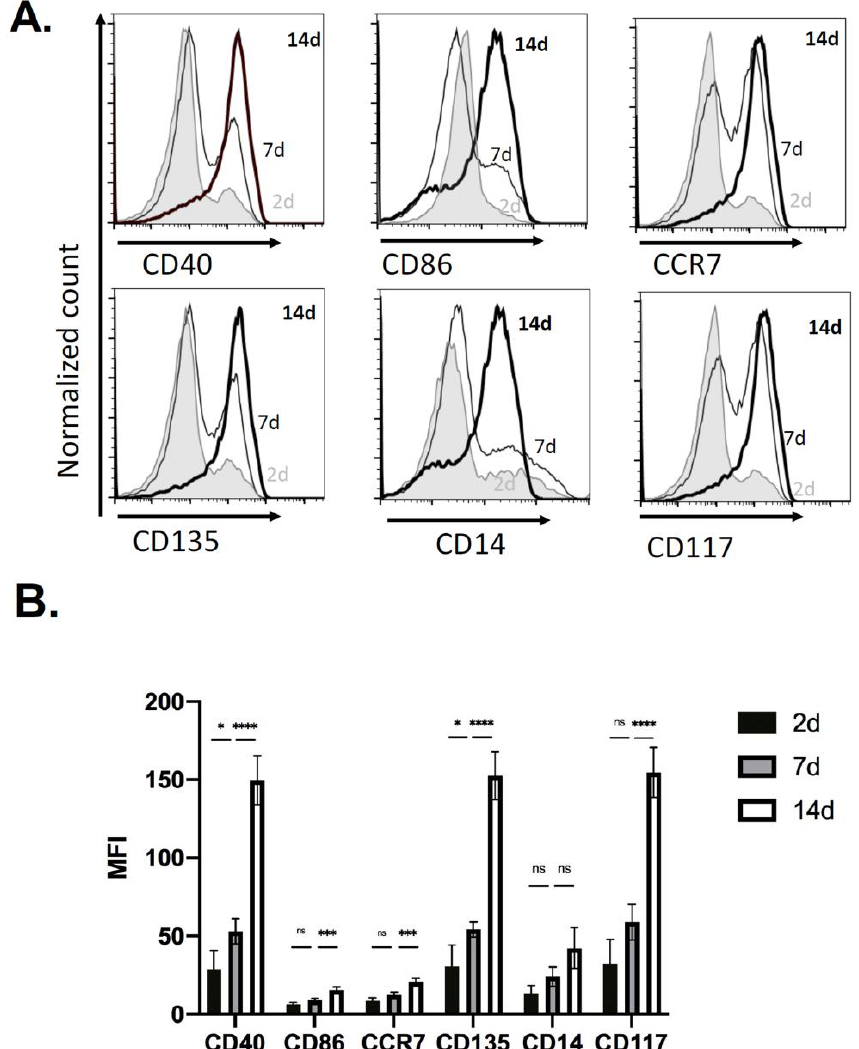
Figure 2. Expression of dendritic cell and hematopoietic stem cell markers in CD11c+ cells in PVA sponge implants. ( A ) Expression of CD40, CD86, CCR7, CD135, CD14, and CD117 on cells recruited to PVA sponges analyzed 2, 7 and 14 days post-implantation. (2 day, shaded; 7 day, thin line; 14 day, bold line). ( B ) Quantification of protein expression on recruited cells (2 day, black shading; 7 day, gray shading; 14 day, open). Data shown are mean ± SD ( n = 5; * p < 0.05, *** p < 0.001, **** p < 0.0001, ns=not significant).